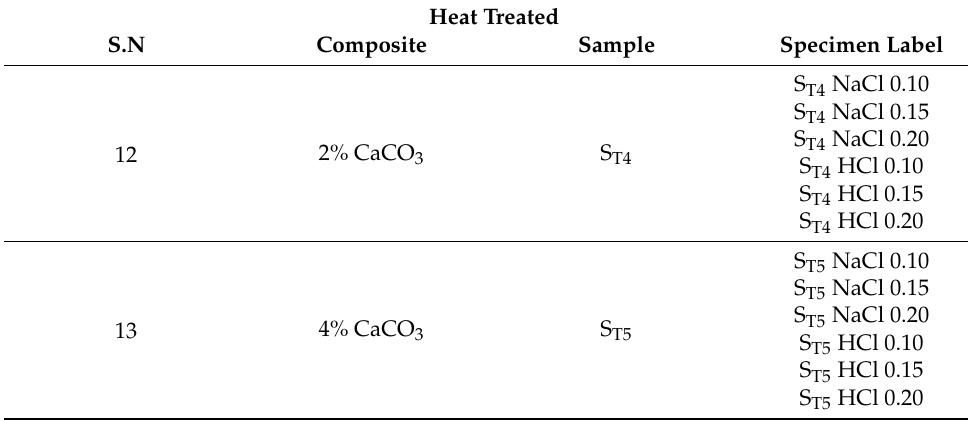
Table 6. Labels and weight of heat-treated CaCO 3